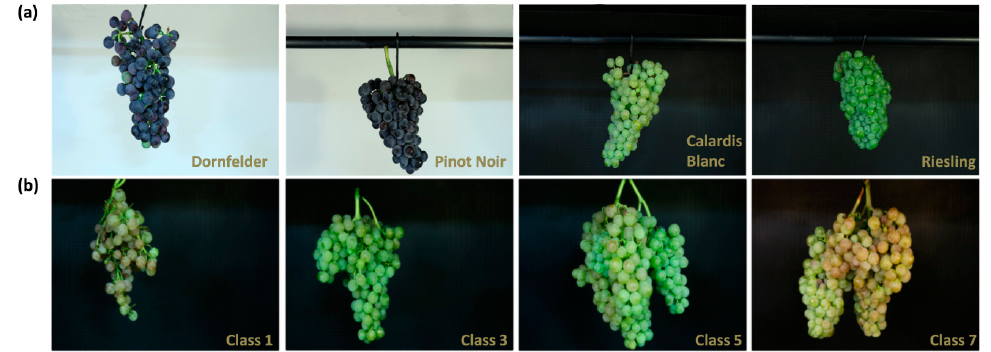
Figure 1. Grape bunches used in this study for data acquisition and parameter extraction. ( a ) Two red (Dornfelder, Pinot Noir) and two white (Calardis Blanc, Riesling) cultivars were used for validation of extracted bunch parameters and field application. ( b ) F1 progenies of GF.GA-47-42 × “Villard Blanc” divided into four different OIV 204 classes (class 1, 3, 5 and 7).